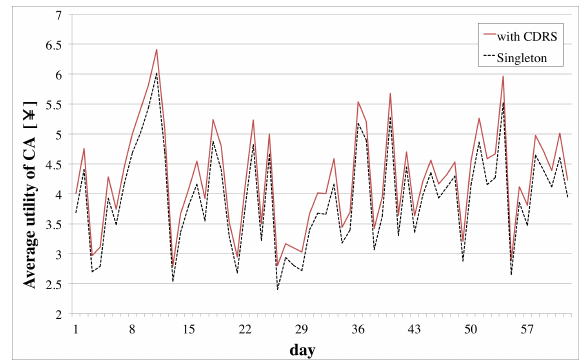
Fig. 6. CA’s average utility with CDRS vs